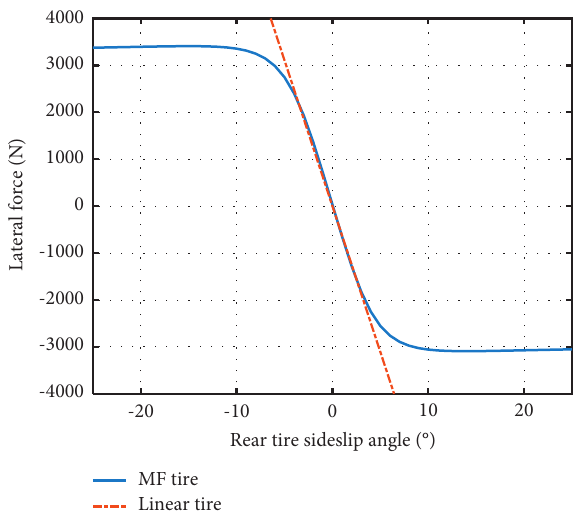
Figure 4: Comparison of lateral force of the rear tire.